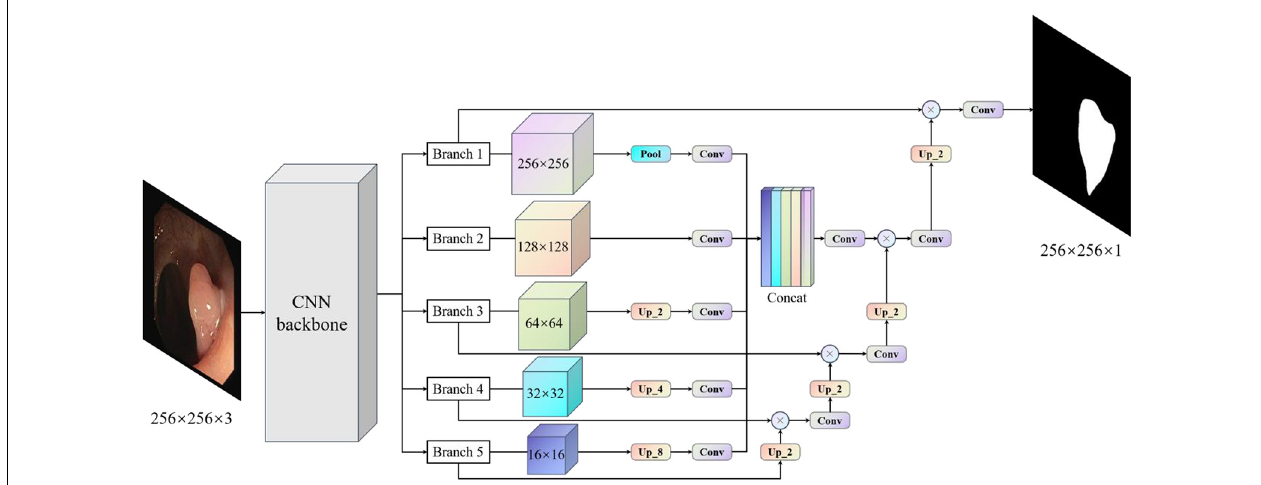
FIGURE 3 | Multi-branch feature fusion network. The backbone initially extracts the features of images, and images with different subsampling multiples are superimposed in an hourglass image pyramid (subsample images have a size larger than 128, and up-sample images have a size smaller than 128, which is equal to 1 × 1 standard convolution for images with size larger than 128). To maximize the use of cross-channel and cross-resolution image branches, each branch is up-sampled and multiplied by the previous layer. Finally, the predicted image of the original image size is